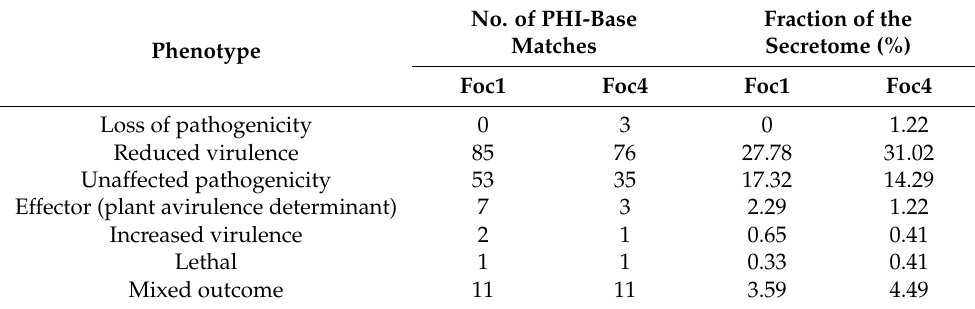
Table 1. Predicted PHI proteins of the secreted proteins of Foc1 and